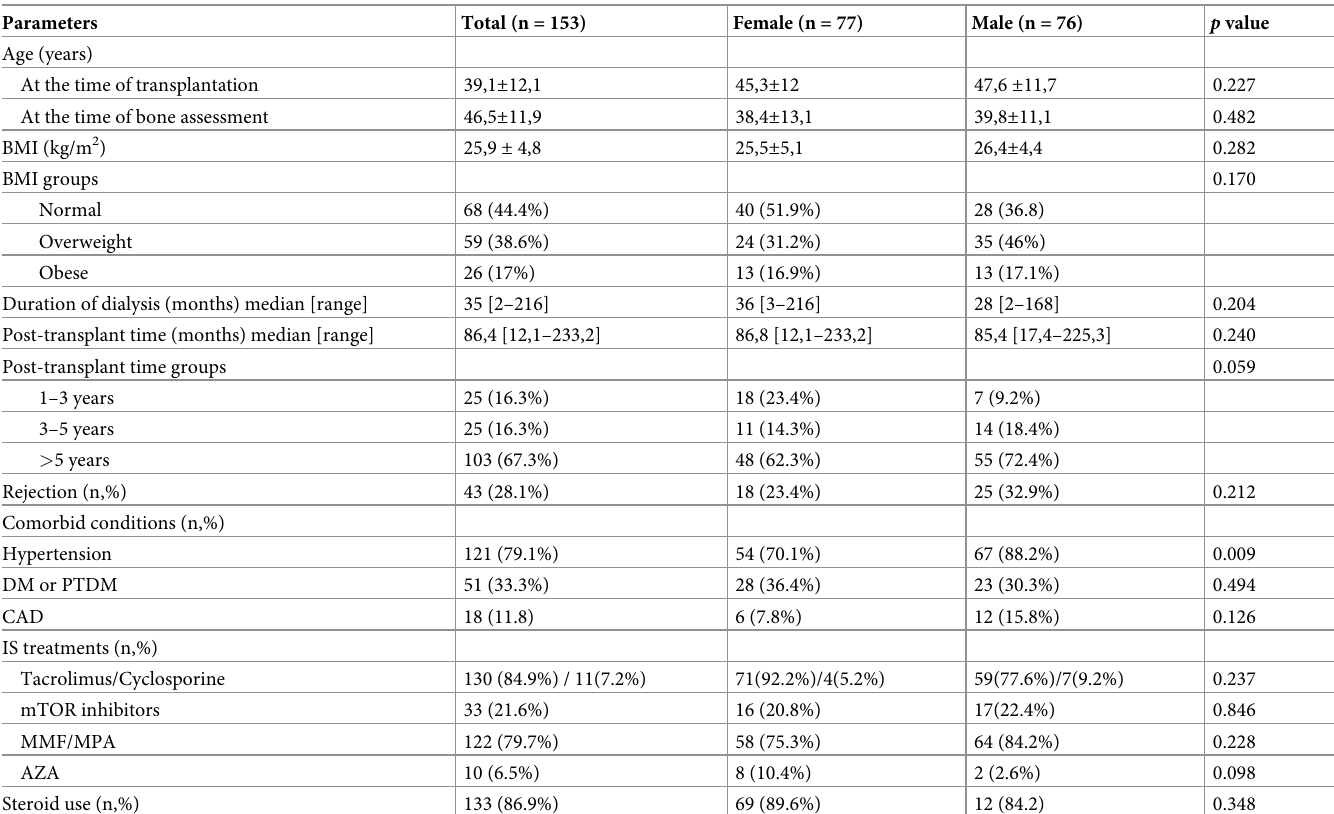
Table 1. Demographic and clinical parameters of the study